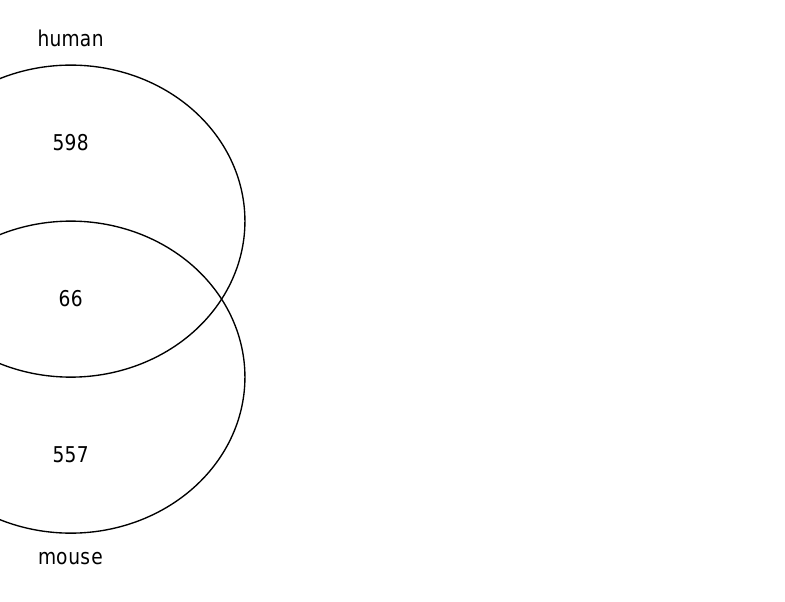
Figure 4. Venn diagram of gene symbols selected using TD-based unsupervised FE for mice (mESC) and humans (HEC-1-A). Table 4. Confusion matrix of gene symbols selected by TD-based unsupervised FE between HAC-1-A (human) and mESC (mouse). Odds ratio is 4.00, P = 1.91 × 10 − 17 . Since only common gene symbols between mice and humans were considered to generate the confusion matrix, the total number of genes considered was less than the total numbers of mouse and human genes